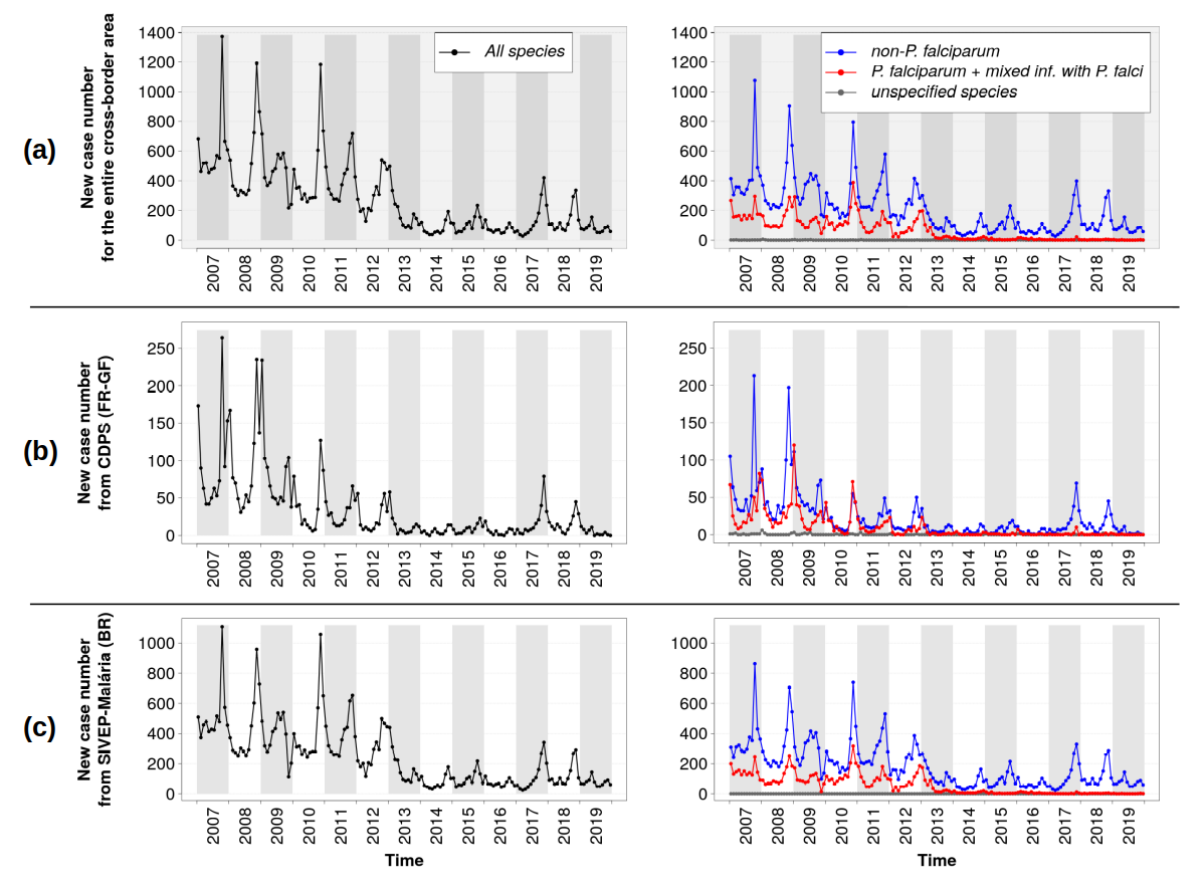
Figure 3. Number of new monthly malaria cases reported in the cross-border area from 2007 to 2019: (a) the cross-border area as a whole; (b) cases recorded in the database of the Department of the Centers for Prevention and Care (Service des Centres Délocalisés de Prévention et de Soins [CDPS]) in French Guiana (FR-GF); (c) cases recorded in the Malaria Epidemiological Surveillance Information System (Sistema de Informações de Vigilância Epidemiológica da Malária [SIVEP-Malária]) in Brazil